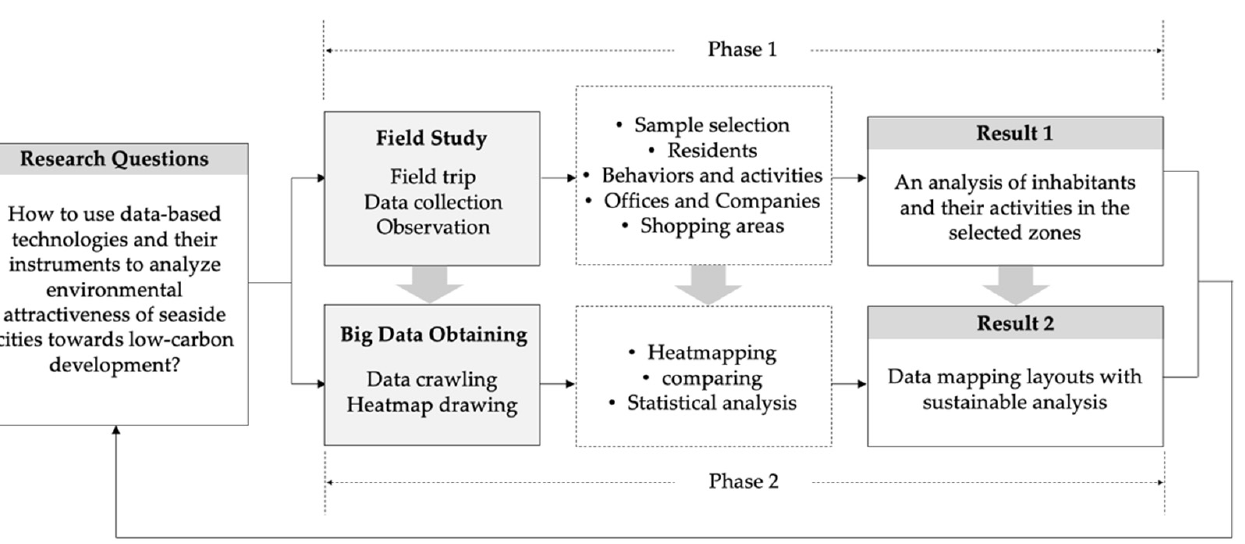
Figure 1. Methodology framework. Source: Authors.